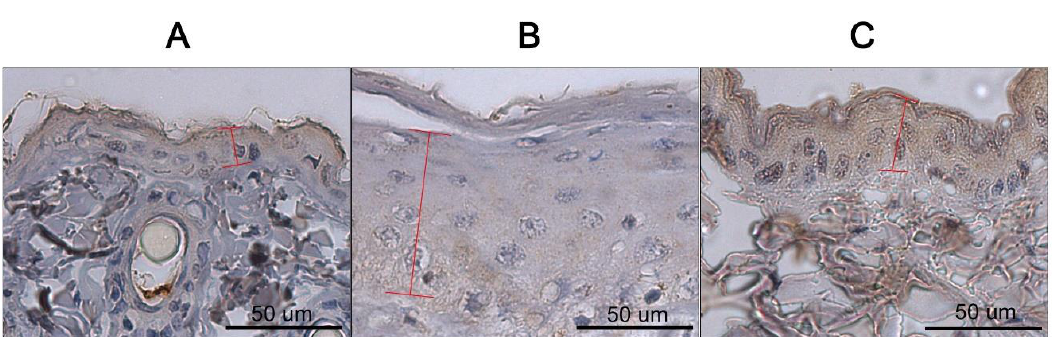
Figure 8. Representative photomicrographs of dorsal skin from each group of mice on day 15 (Filaggrin antibody staining 400×). ( A ) dorsal skin of the control group; ( B ) dorsal skin of the atopic dermatitis (AD) group; ( C ) dorsal skin of the leucine-rich glioma inactivated 3 (LGI3) group. Brown stained part in the skin epithelium is from filament aggregating protein (FLG). A red indicator: Epithelial skin tissue. In the control group, FLG was evenly expressed in the epidermis, and the LGI3 group showed a high intensity of brown staining color in the epidermis.